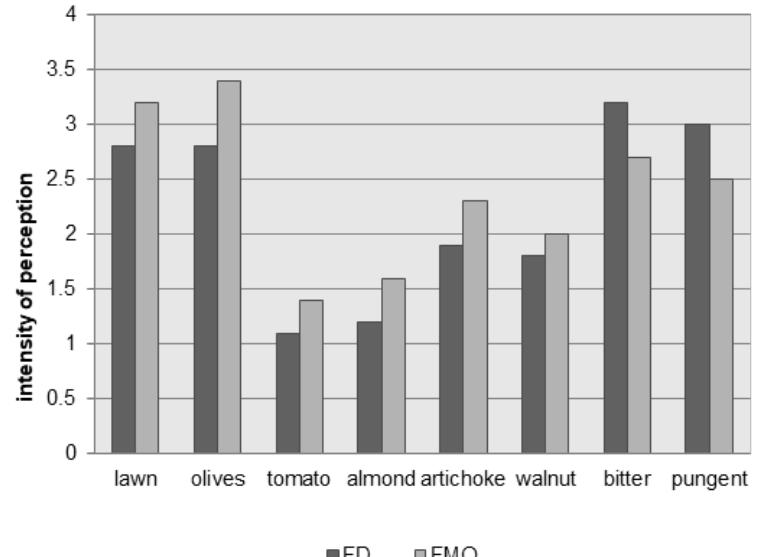
Figure 5. Sensory profiles of oils from fruits of two batches of Provenzale cultivar obtained with the same processing diagram except for crushing. FD = hammer crusher; FMO = stone mill. Figures were obtained on the basis of data collected by our team. Data represent the average of intensities recorded by fully trained tasters in three independent trials. The oils were presented according to an experimental design, which minimized possible biases and carry-over effects. Standard deviation ranged between ± 0.2–0.5. (Source: Authors; unpublished results).